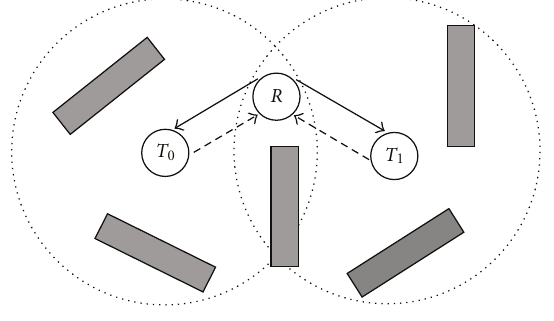
Figure 1: Network model.